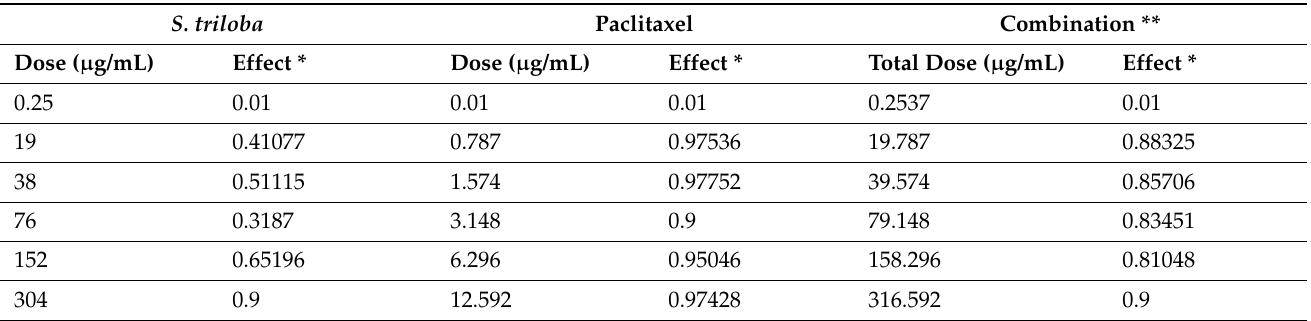
Table 3. Summary of dose and effect values generated from the combination experiment (SKOV3